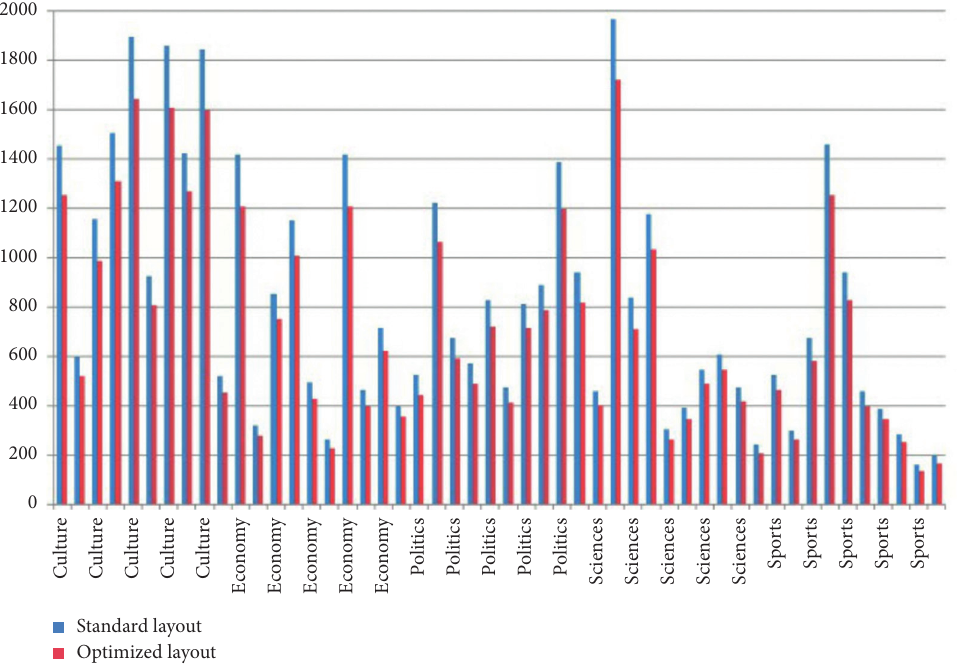
Figure 4: The estimated time (in seconds) to type the text for each test case.